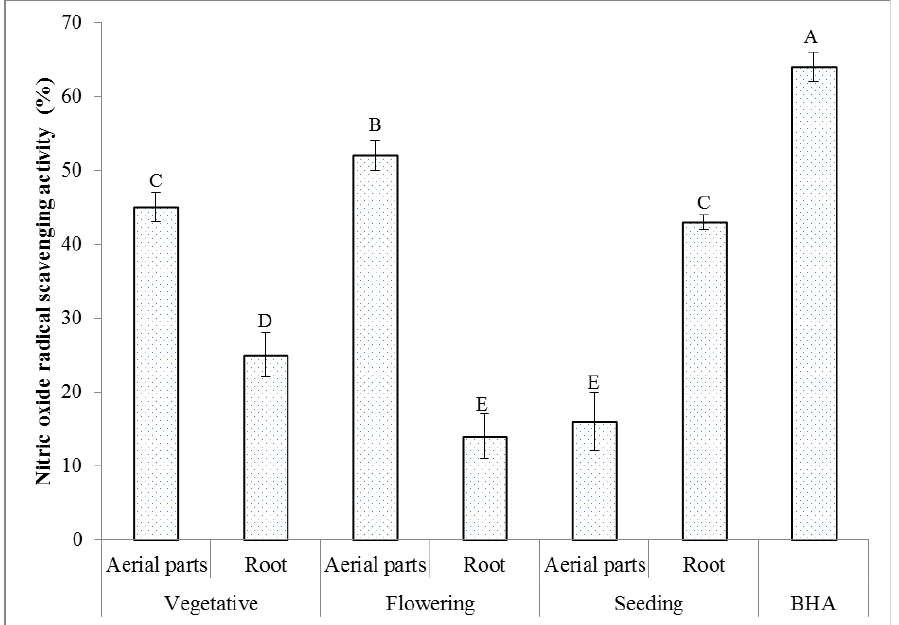
Figure 4. Nitric oxide radical scavenging activity ( n = 3) of the extracts of the T. polium aerial parts and root at different phenological stages. The extract concentration is 200 µg/mL. Various letters indicate statistically significant differences ( p < 0.05).